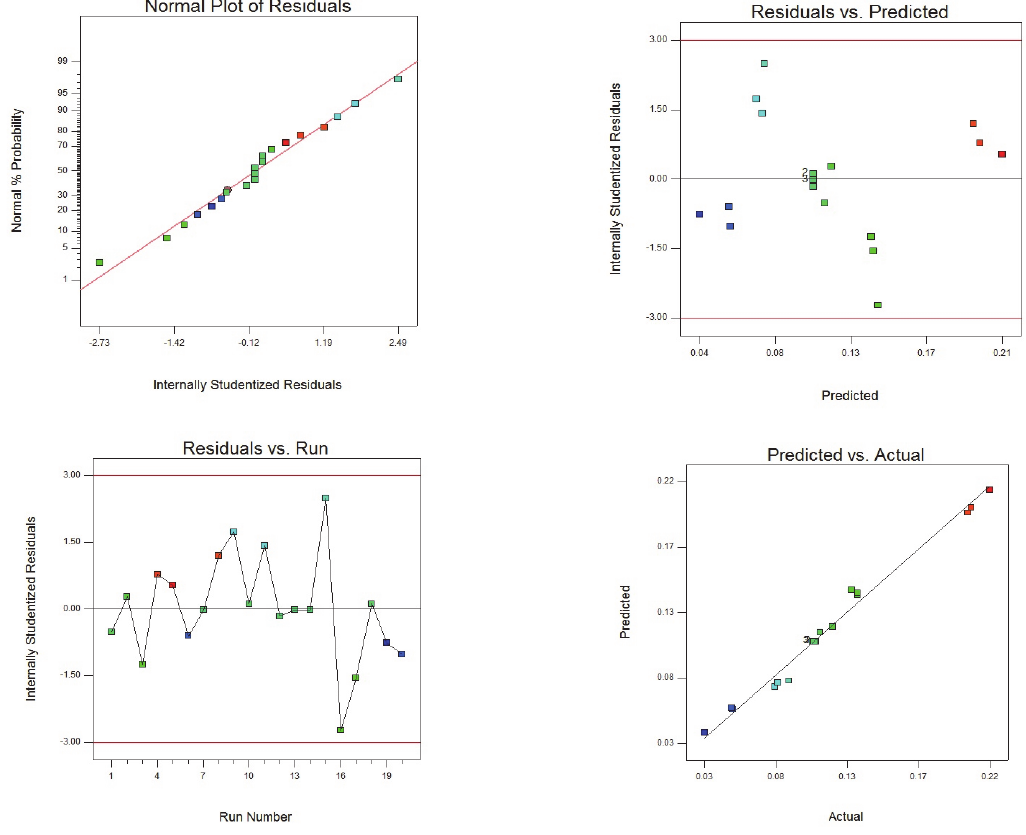
Fig. 6. Residual plots for surface roughness of post turning composite specimen